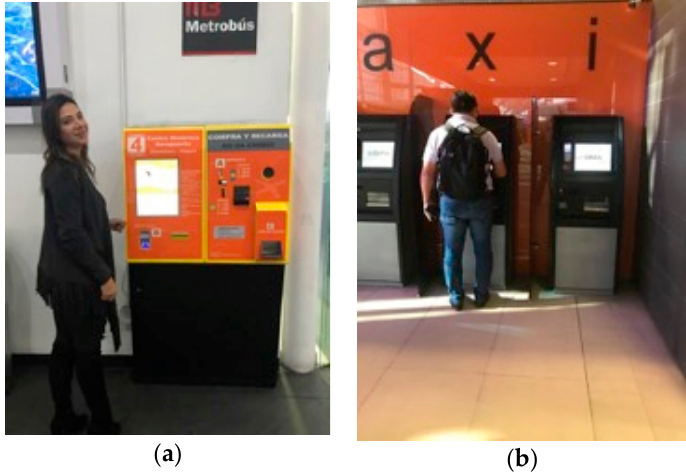
Figure 20. Left image ( a ) kiosk vending machine for the Metrobús in Mexico City. Right image ( b ) taxi tickets at the Monterrey airport. Both have only been designed for people of average height.